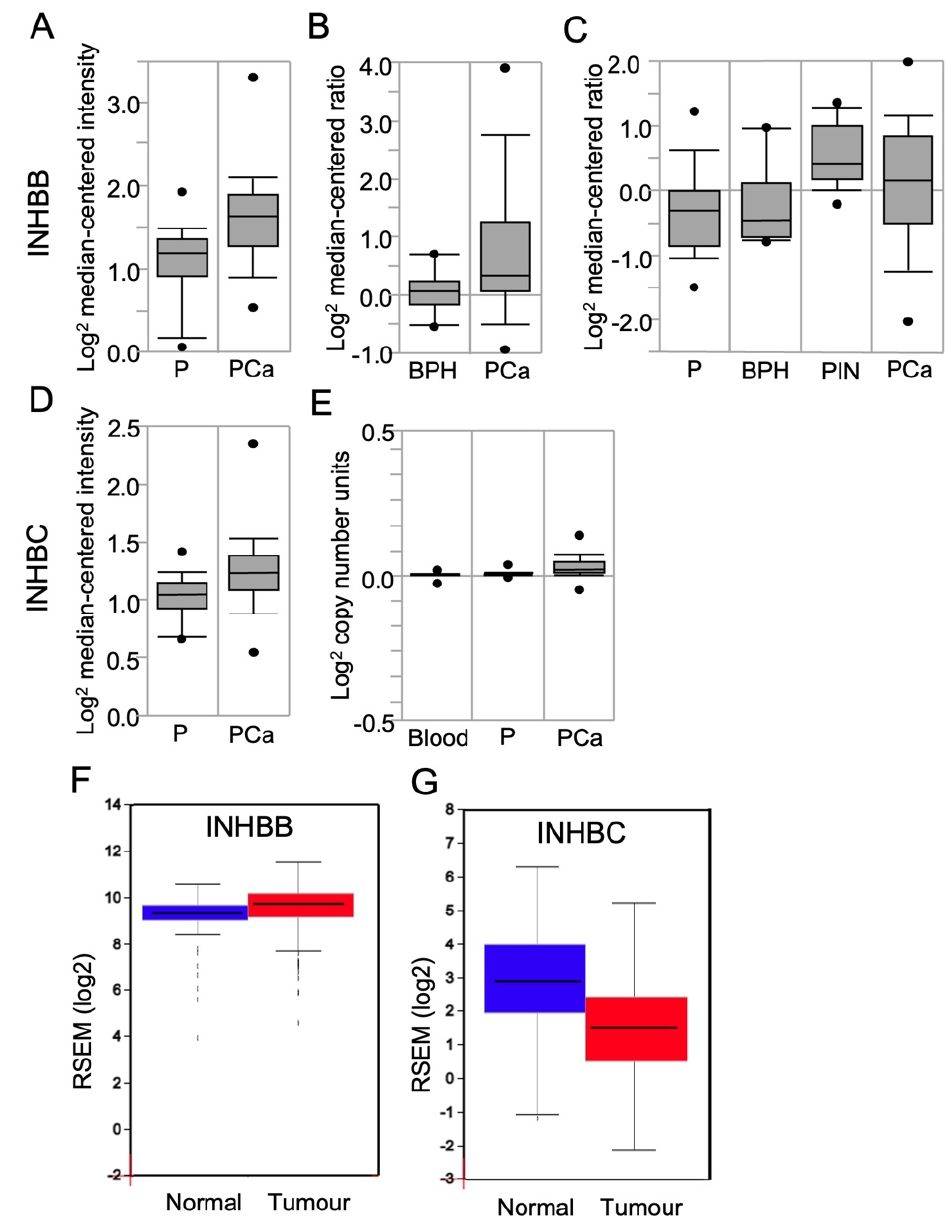
Figure 2. Box plots derived from gene expression data in Oncomine or FireBrowse, comparing results for human prostate expression of INHBB and INHBC. INHBB expression was shown in data sets from ( A ) Yu Prostate, comparing the prostate gland (P; n = 23), and prostate carcinoma (PCa; n = 65); ( B ) Luo Prostate, comparing benign prostatic hyperplasia (BPH; n = 9) and PCa ( n = 16); ( C ) Tomlins Prostate data, comparing the normal prostate (P; n = 25), BPH ( n = 10), prostatic intraepi- thelial neoplasia (PIN; n = 13), and PCa ( n = 46). INHBC expression was shown in data sets from ( D ) Liu Prostate data, comparing prostate gland samples (P; n = 13) and PCa ( n = 44); ( E ) The Cancer Genome Atlas (TCGA) comparing blood ( n = 148), the prostate gland (P; n = 61) and PCa ( n = 45). ( F ) FireBrowse RNASeq data comparing INHBB expression in normal prostate samples (blue; n = 52) and tumour samples (red; n = 498). ( G ) FireBrowse RNASeq data comparing INHBC expression in normal prostate samples (blue; n = 45) and tumour samples (red; n = 457). Figures are presented as box plots. The box midline is the median, top and bottom of the box represent 75th and 25th percentiles, and top and bottom whiskers represent 90th and 10th percentiles.